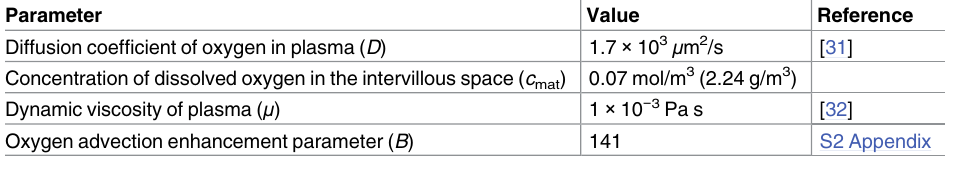
Table 2. Literature-based and calculated parameters used in the formulation of the problem and the estimation of oxygen advection enhancement by fetal